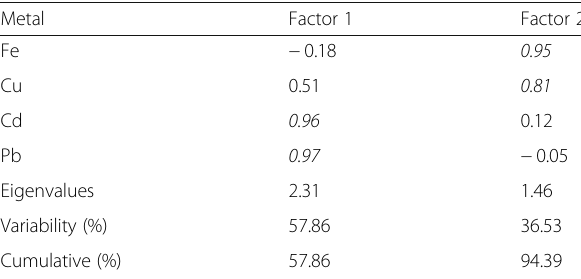
Table 4 Factor loading for heavy metal after varimax rotation using PCA